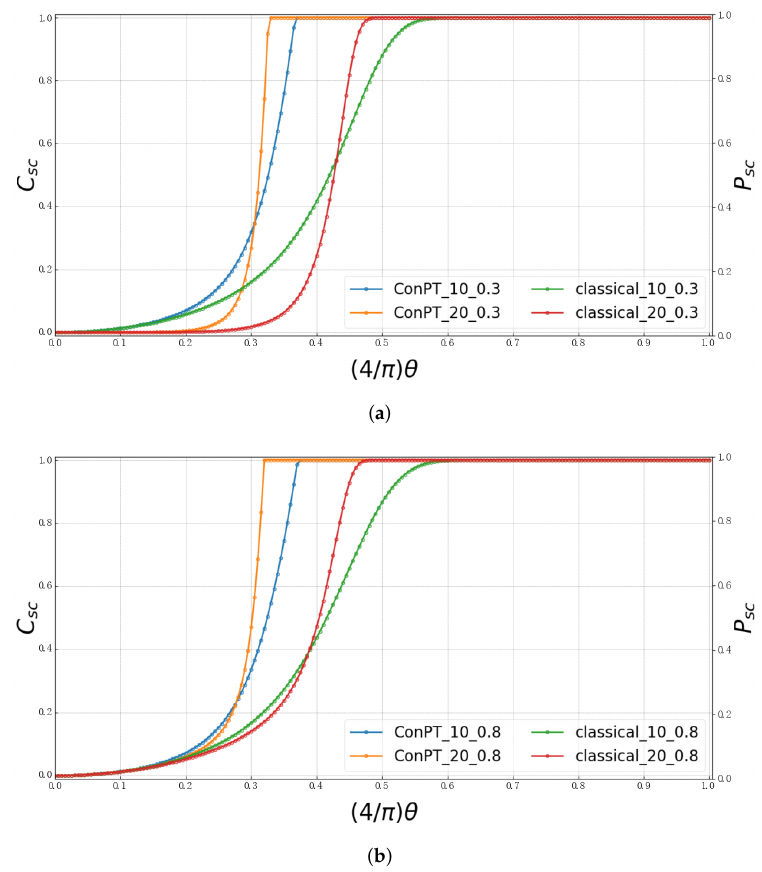
Figure 11. Effects of ( a ) p re = 0.3 and ( b ) p re = 0.8 on the percolation threshold of WS quan- tum networks.